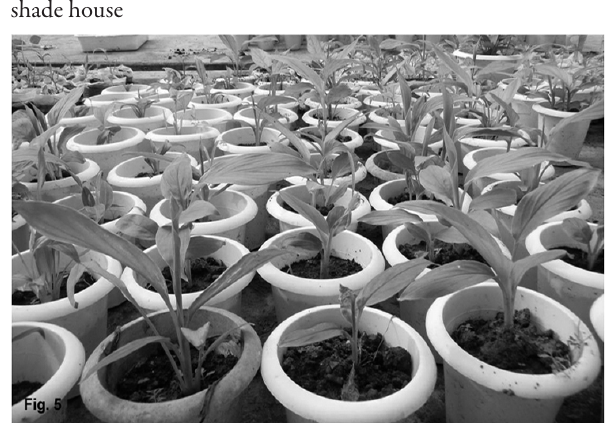
Fig. 5. Established plants without Silver nitrate in shade house